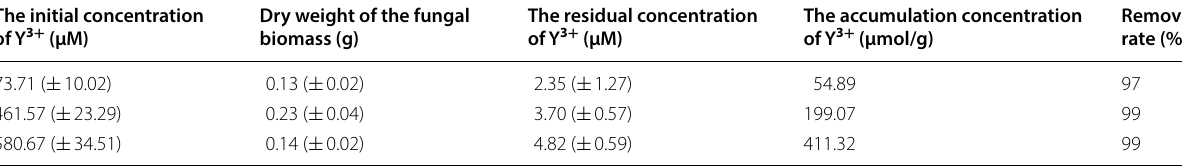
Table 2 Accumulation of Y 3 + during the growth process of Penicillium sp. ZD28 The initial concentration Dry weight of the fungal of Y 3 + (µM) biomass